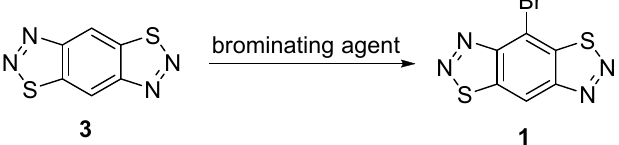
Table 1. Bromination of benzo[1,2- d :4,5- d ′ ]bis([1,2,3]thiadiazole) 3 .